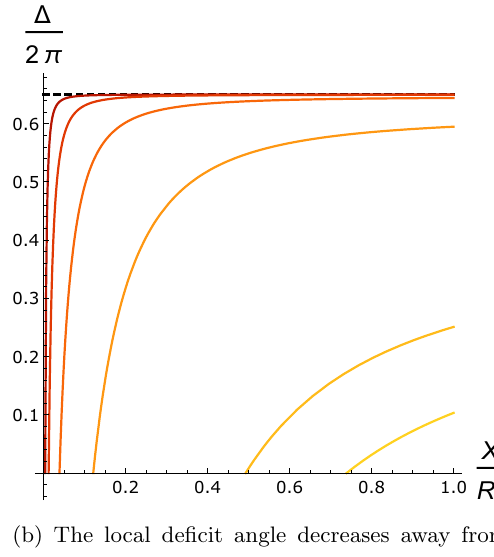
(a) Radial embedding diagram ( Y = 0): rotation (b) The local de(cid:12)cit angle decreases away from leads to a wider inverted cone. To avoid an excess the brane until it turns eventually negative, cor- angle, the extra space has to be capped by a sec- responding to an excess angle. ond (sub-critical) brane sitting to the right of the dashed line. Figure 6 . Deformed inverted cones for super-critical tension, (cid:22) (cid:21) = 1 : 35, and (cid:22) ! 2 2 (cid:8) (cid:9) 10 (cid:0) 5 ; 10 (cid:0) 4 ; 10 (cid:0) 3 ; 10 (cid:0) 2 ; 10 (cid:0) 1 ; 0 : 15 [from dark to light, corresponding to the dots in the blue (dark) region in (cid:12)gure 3(a)]. The dashed curve represents the static case ((cid:22) ! = 0). The brane \sits" at X =